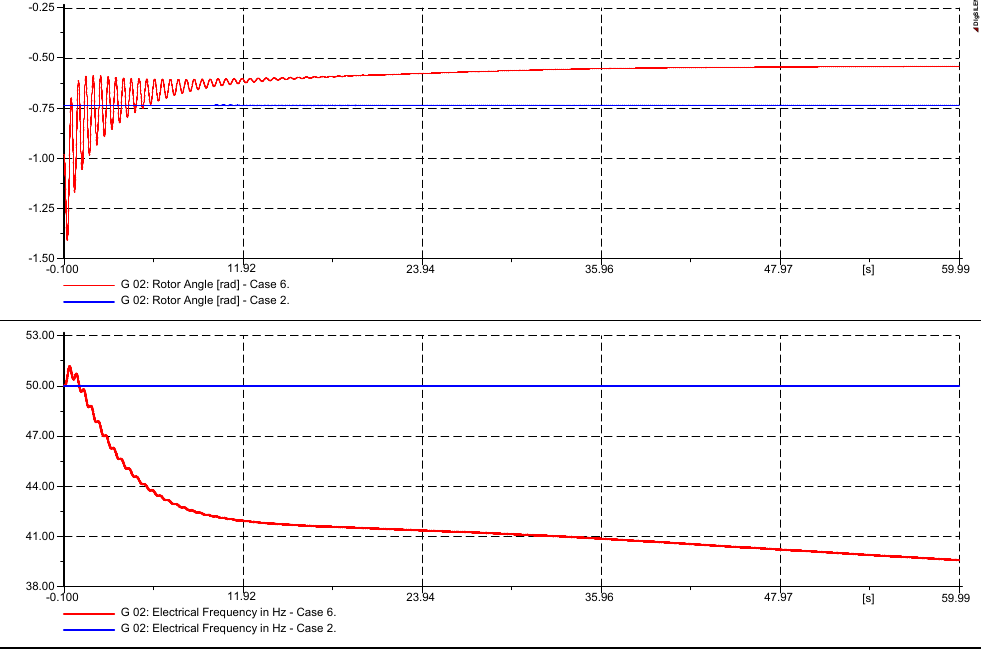
Figure 10. Angles and frequency of Machine 2 in Case 2 versus Case